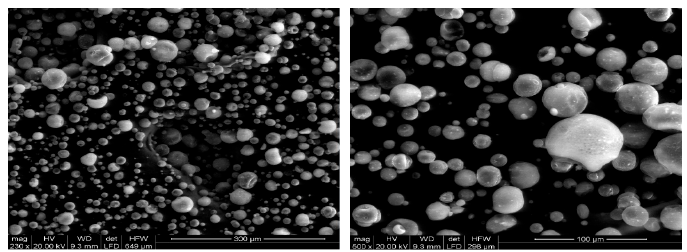
Figure 2. SEM of vapor induced phase separation (VIPS) capsules micrographs with small magnitude.